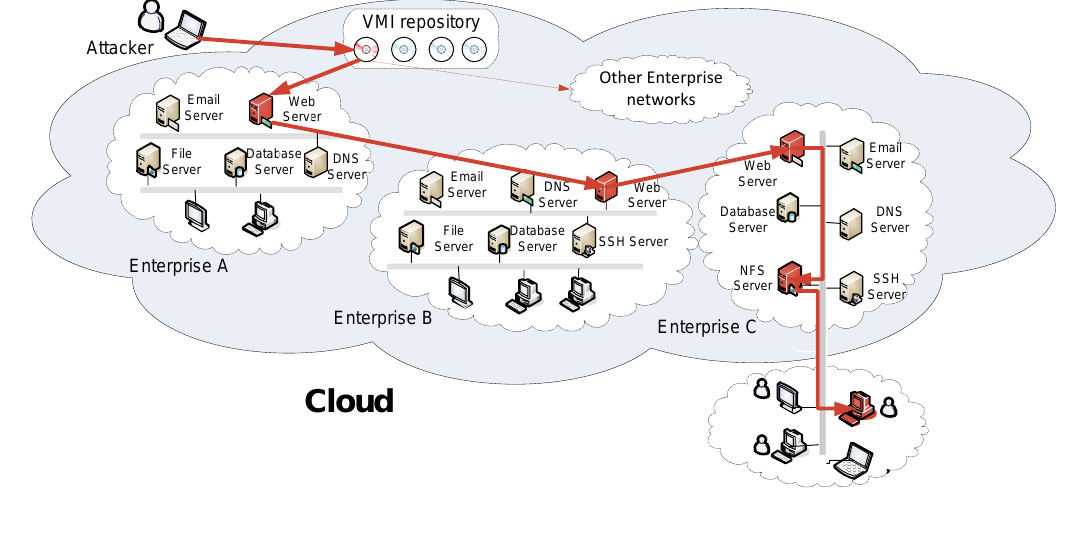
Figure 1. The Attack